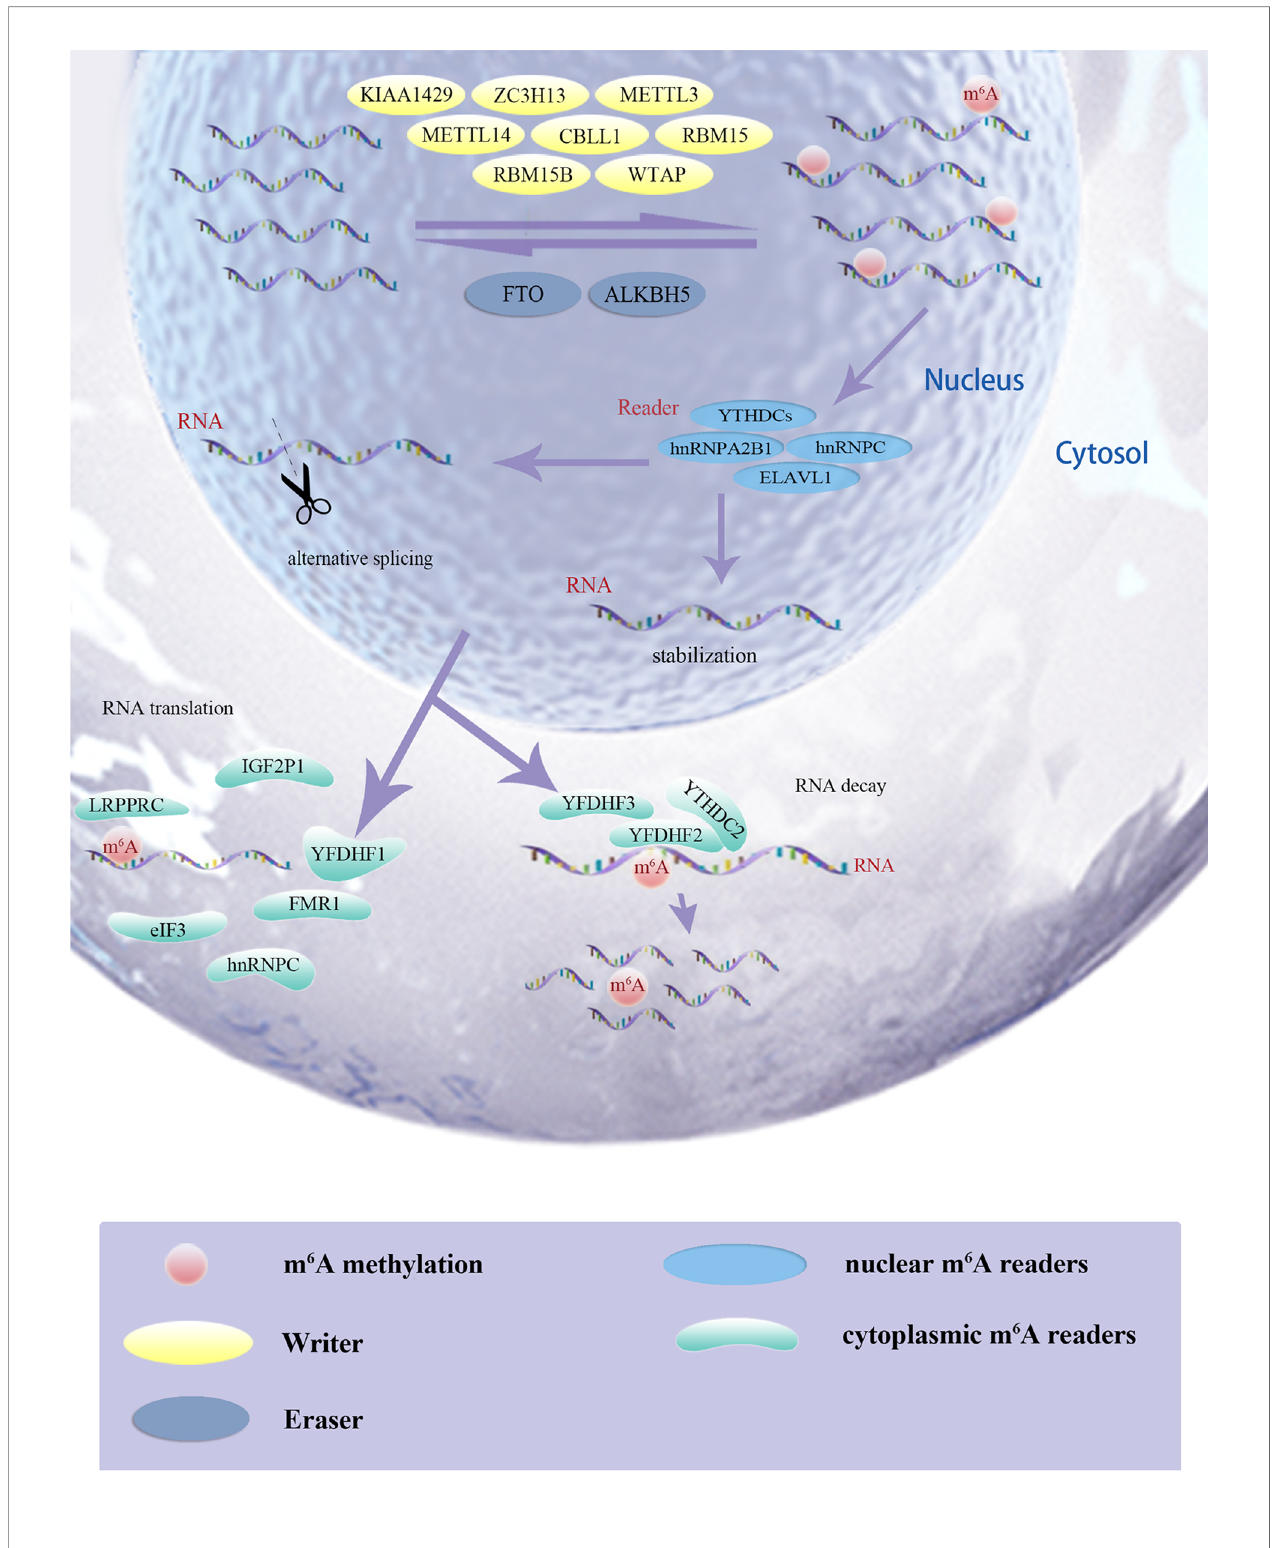
FIGURE 1 | The m 6 A modi fi cation has been implicated in various cellular and physiological events, including carcinogenesis, and the mechanism of m 6 A modi fi cation was simply depicted.